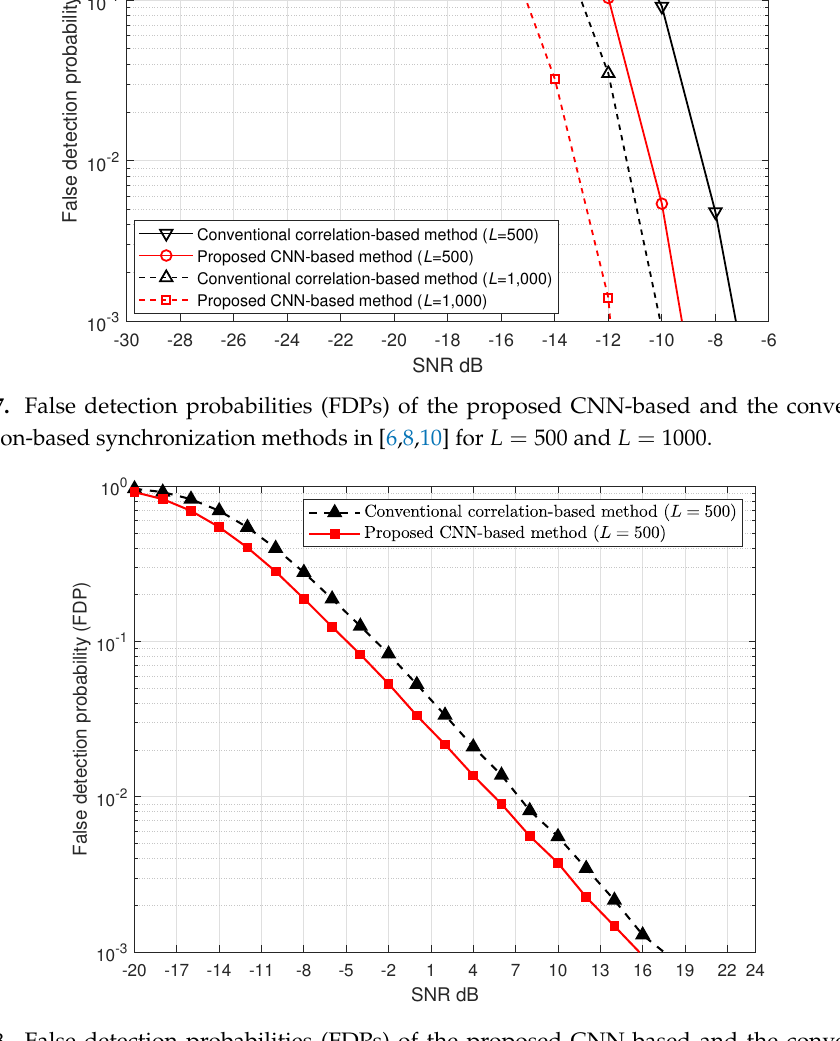
Figure 8. False detection probabilities (FDPs) of the proposed CNN-based and the conventional correlation-based synchronization methods in [6,8,10] for L = 500 in fading